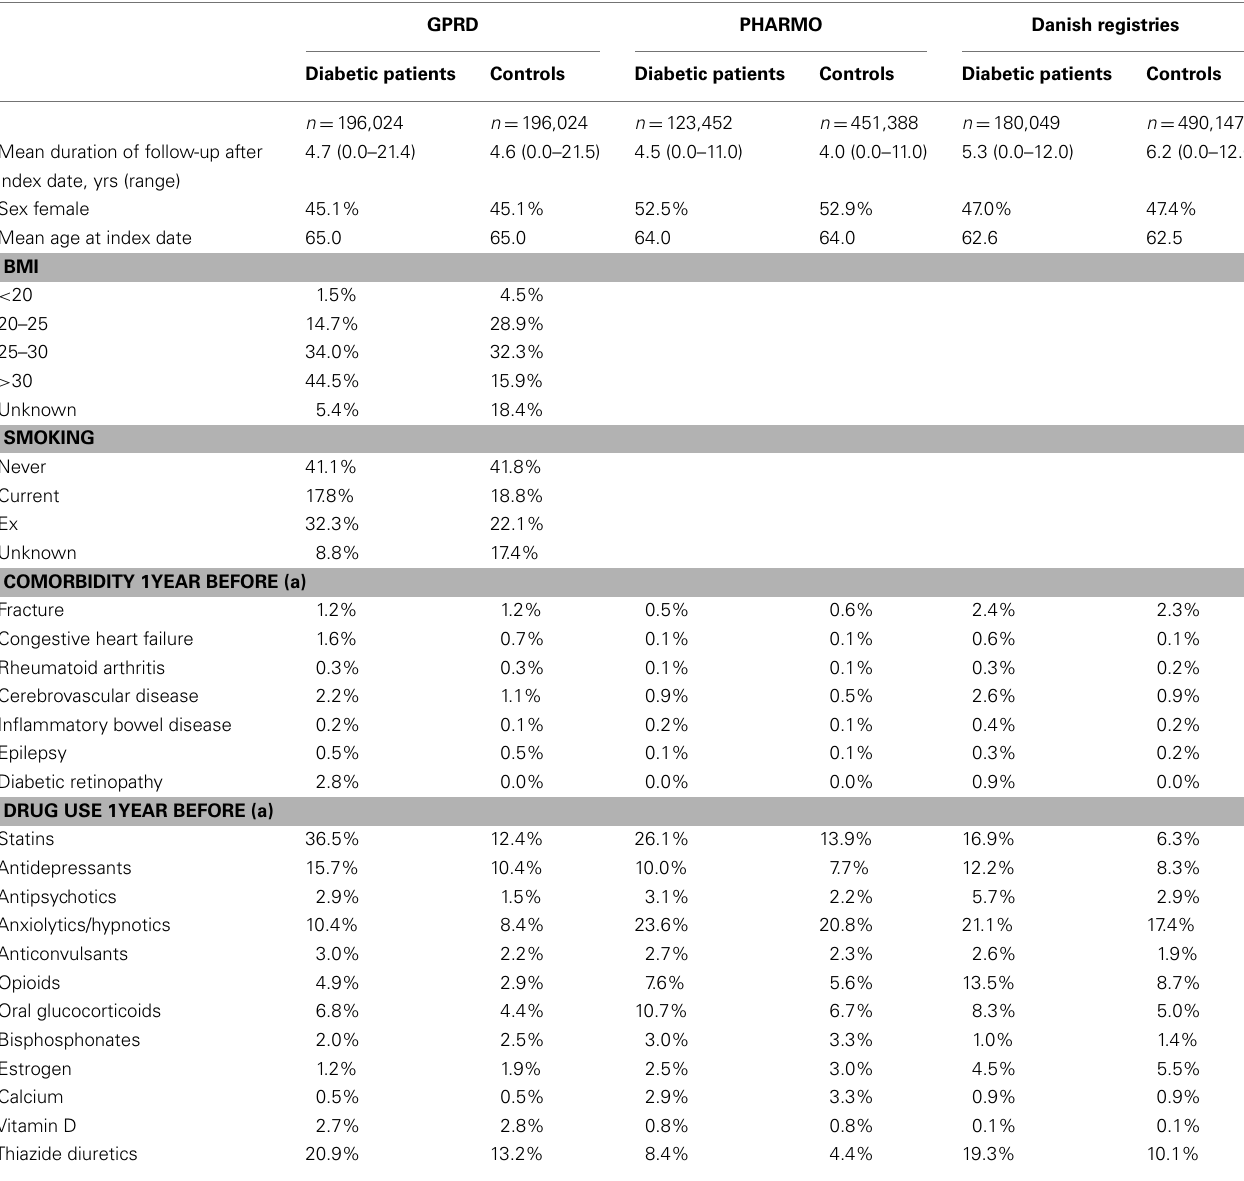
Table 1 | Baseline